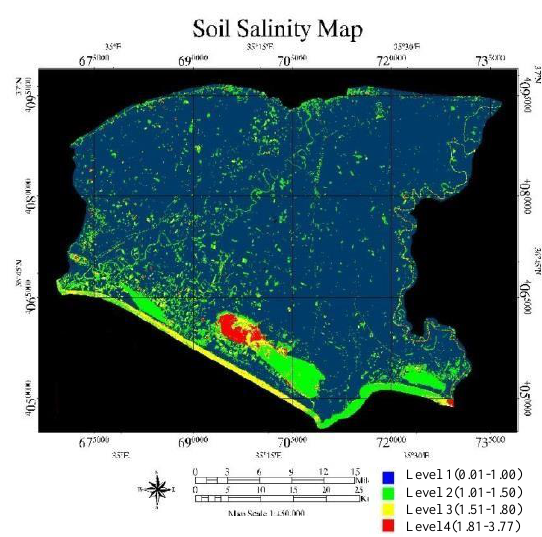
Figure 7. Soil salinity map according to DSI’s ranges.